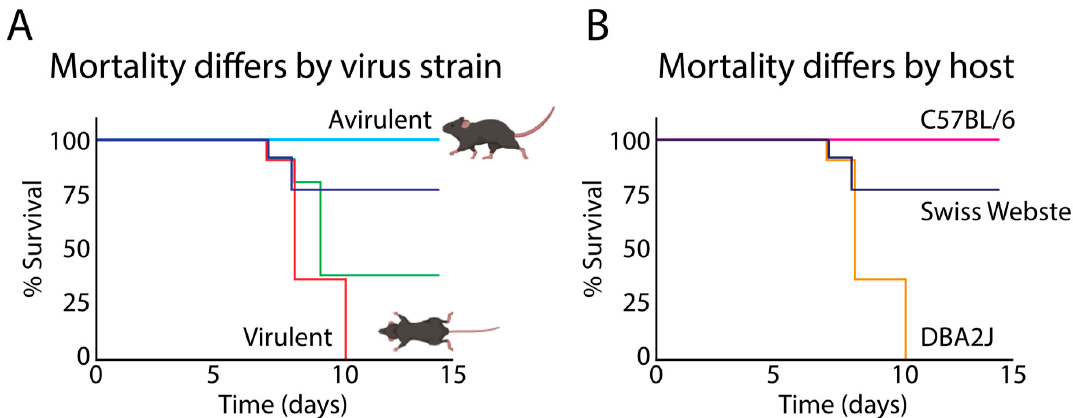
Figure 4. HSV-1 neurovirulence is strain- and host-dependent. ( A ) Different strains of HSV-1 (as represented by the different colored lines) exhibit distinct abilities to reach the CNS from inoculation at peripheral sites, causing variability in disease outcome in infected animals. Differences in the ability of specific HSV-1 strains to travel to the CNS can be the result of genomic variability between strains as well as ( B ) host-specific factors. These are schematized mortality data adapted from [49,52]. Mouse illustrations from BioRender.com.